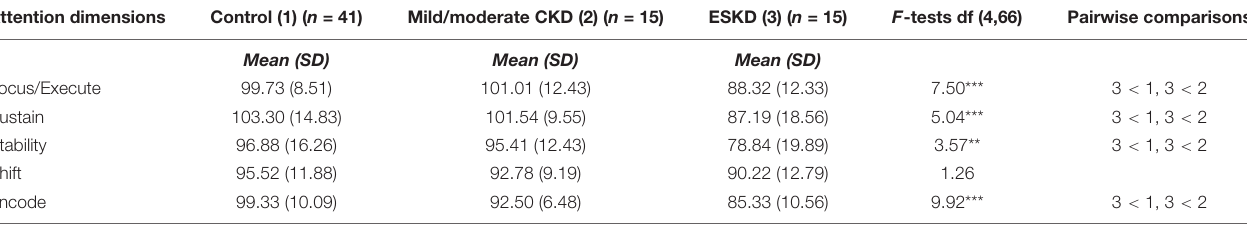
TABLE 3 | Attention dimensions by severity subgroup adjusted for chronological age and maternal education. Attention dimensions